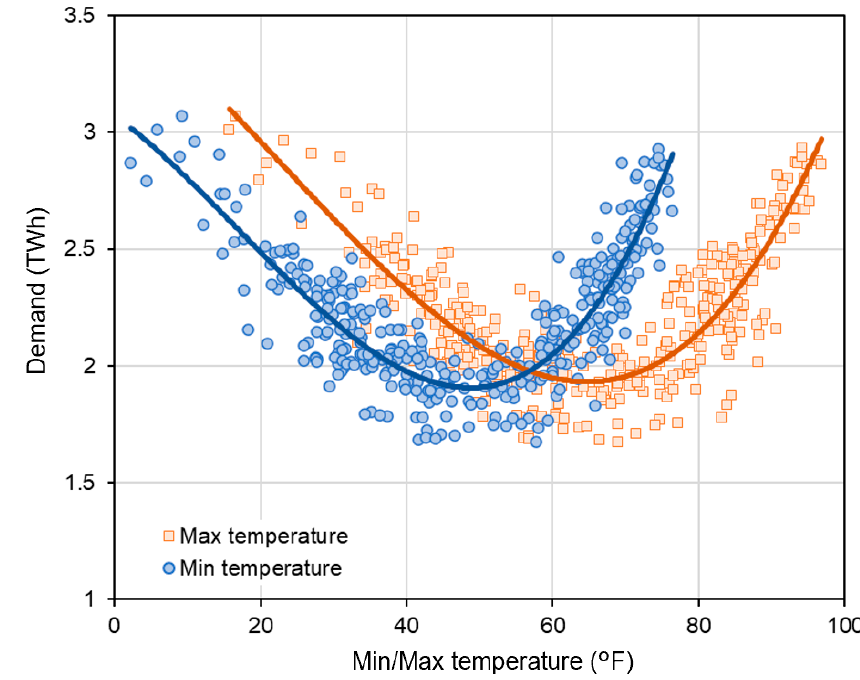
Figure 1. Relationship between temperature and electricity demand in PJM (2018).